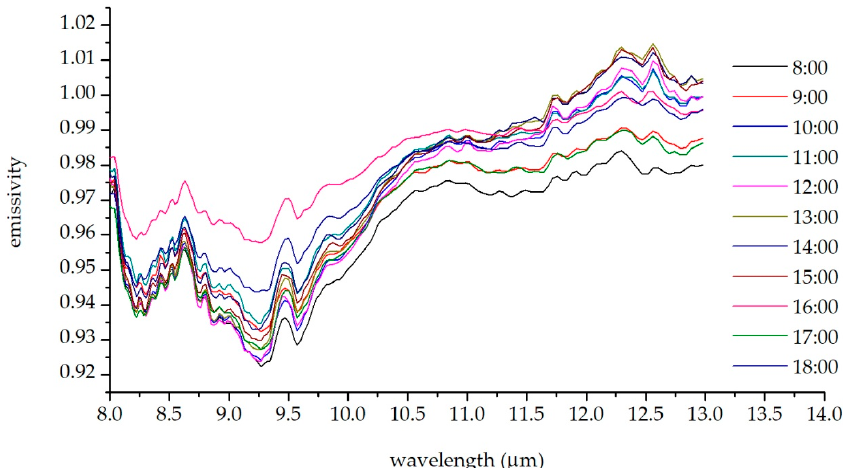
Figure 2 . Measured emissivity spectral on 24 May 2019.